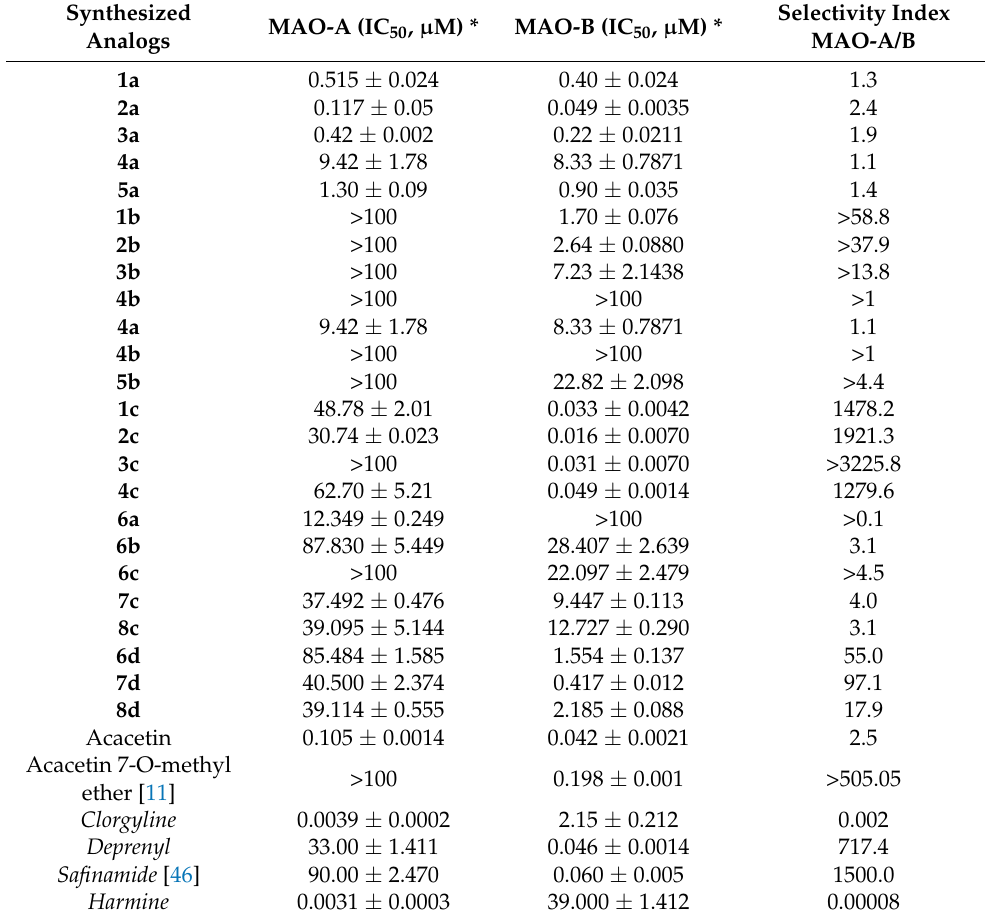
Table 2. Inhibition (IC 50 values) of recombinant human monoamine oxidases A and B by acacetin 7- O -methyl ether analogs and intermediates.